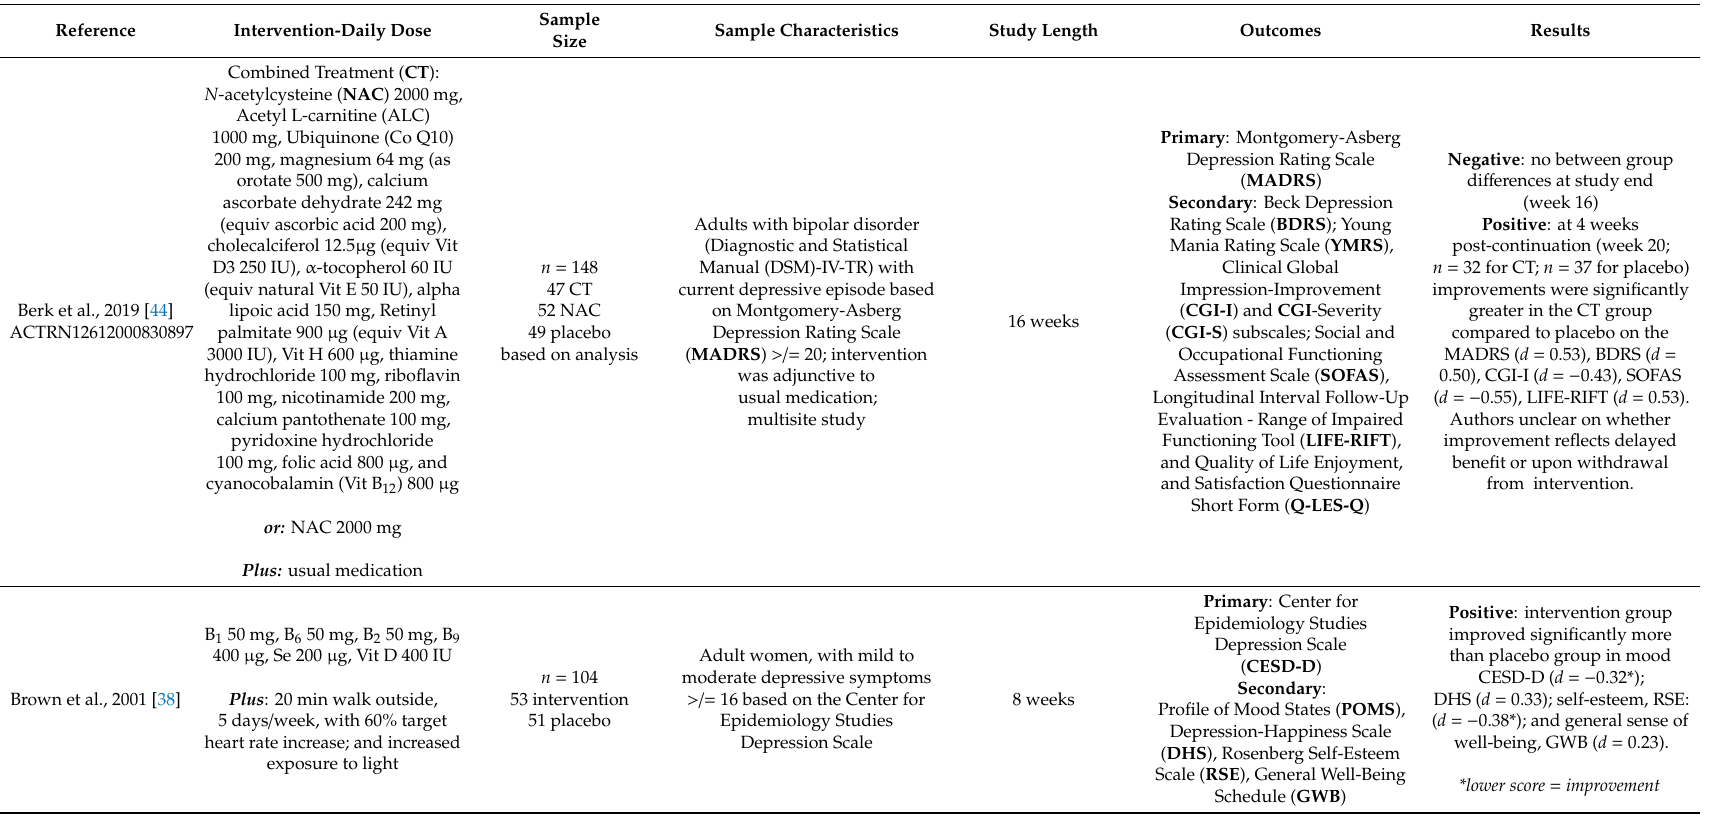
Table 1. Depression Studies ( n =